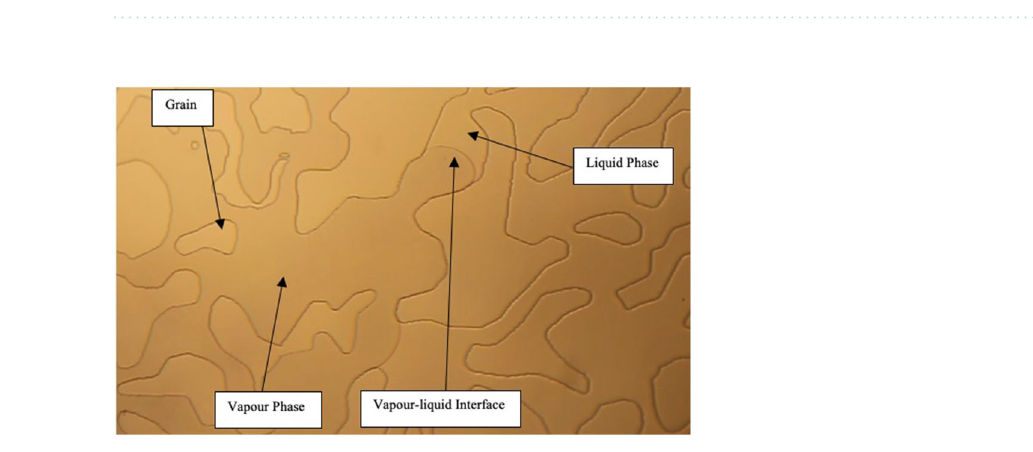
Homogenous model (0.11 mm grain diameter and 0.01 mm pore throat)